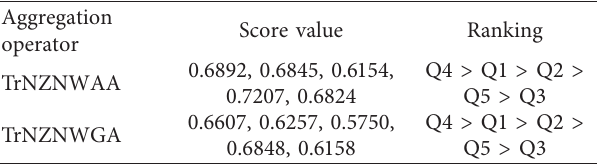
Table 1: Results of the MDM approach based on the TrNZNWAA and TrNZNWGA operators and the score function.